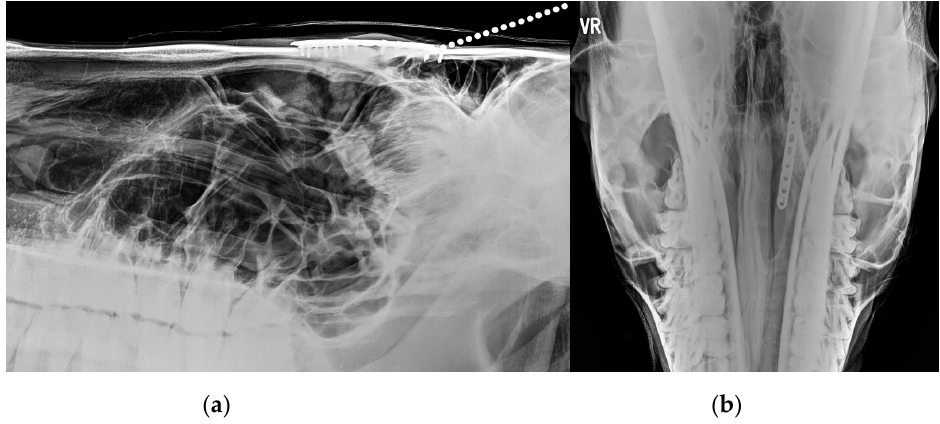
Figure 9. ( a , b ): LL ( a ) and DV ( b ) X-ray of one of the horses with internal fixation of the suture lines after surgery. Note two 10-hole plates positioned 2.5 cm on the left and right of the midline.